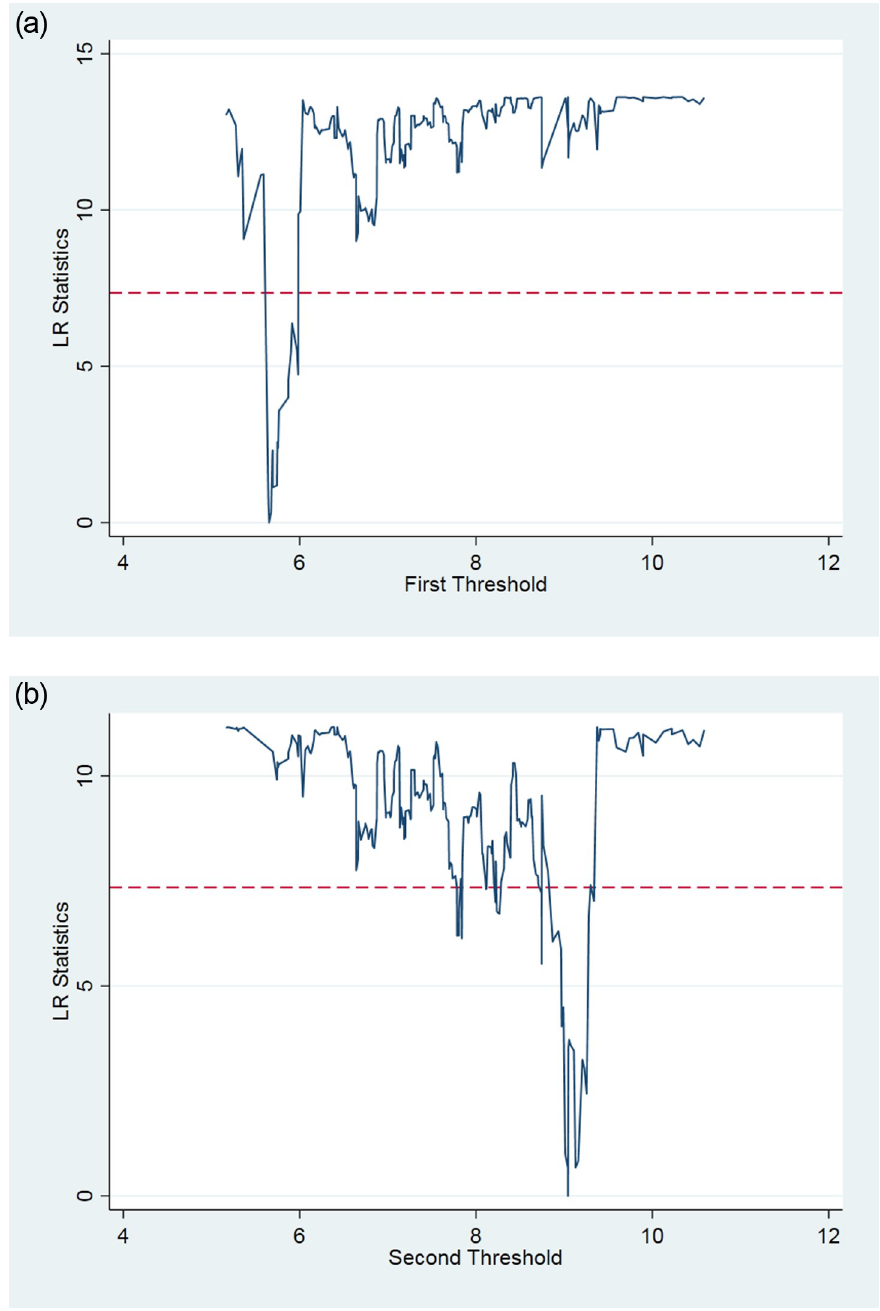
Fig 2. a. The LR map corresponding to the first threshold estimate of FDI quantity. b. The LR map corresponding to the second threshold estimate of FDI